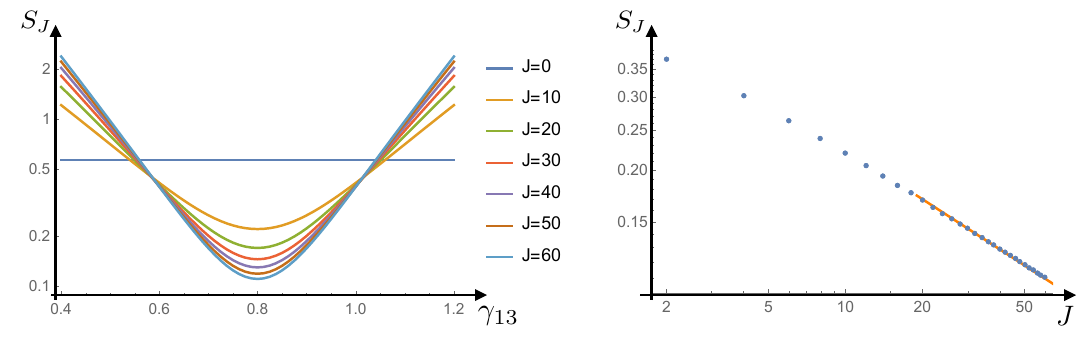
. On the left, one 5